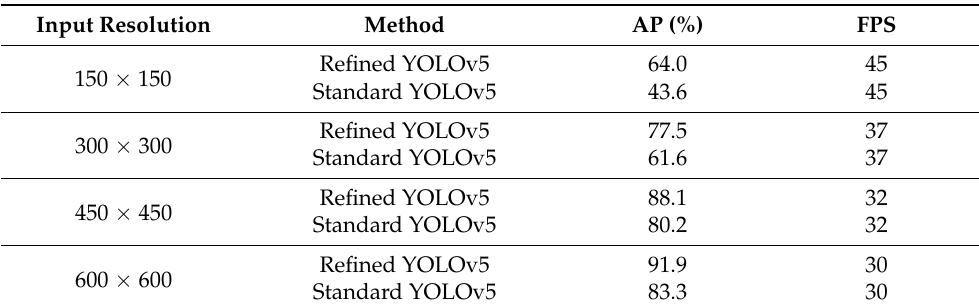
Table 3. Performance comparison with different resolution images of refined YOLOv5 network and standard YOLOv5